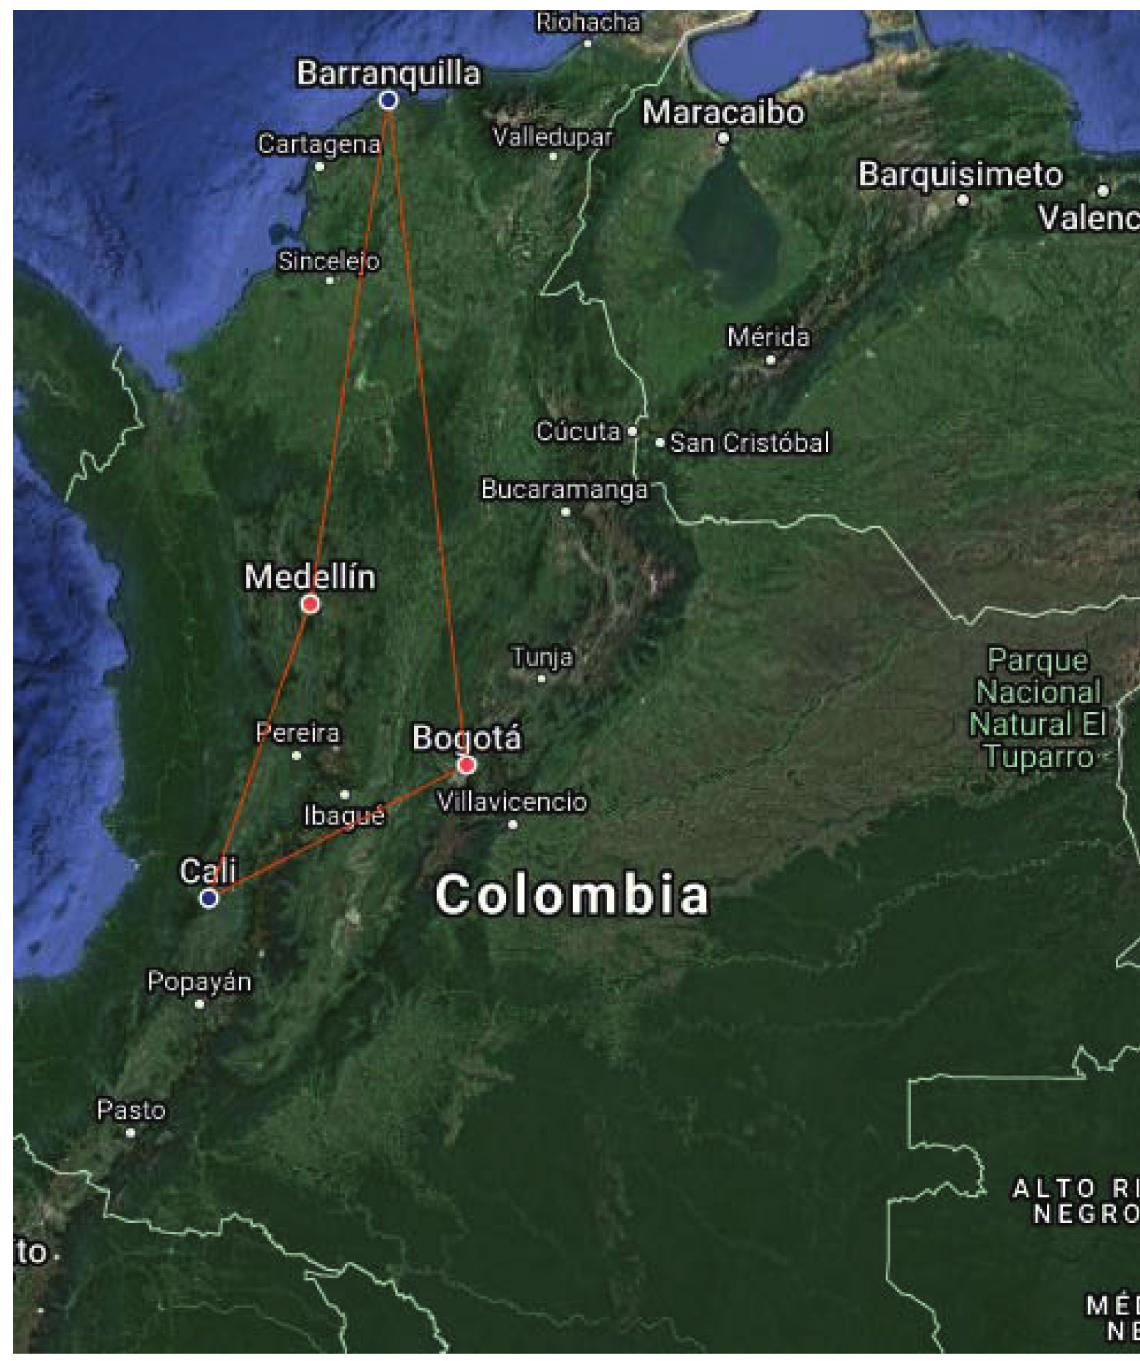
Figure 2: Georeferencing the supply network: manufacturers are located in the areas pointed in red, while the points of demand are located in the areas pointed in